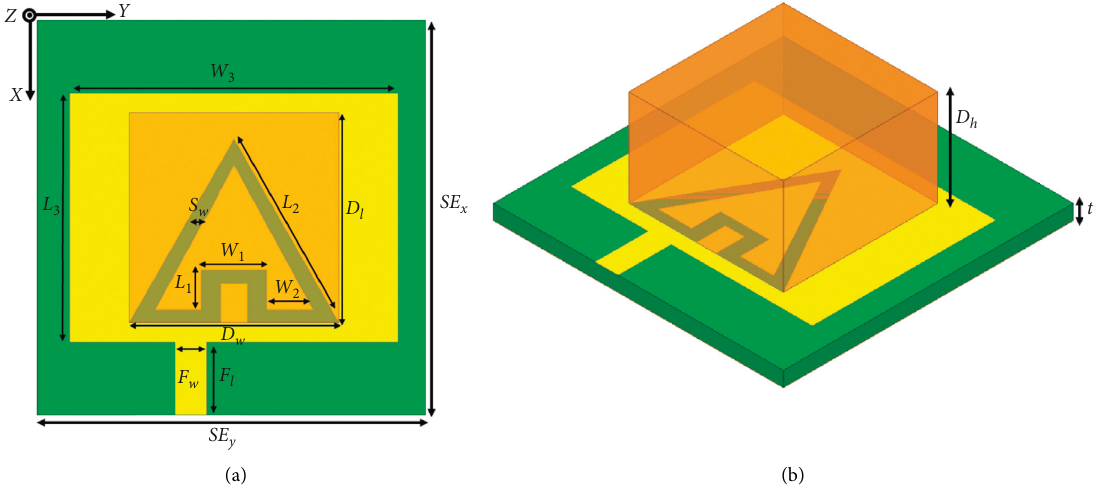
Figure 1: The proposed antenna element view: (a) top and (b) perspective.